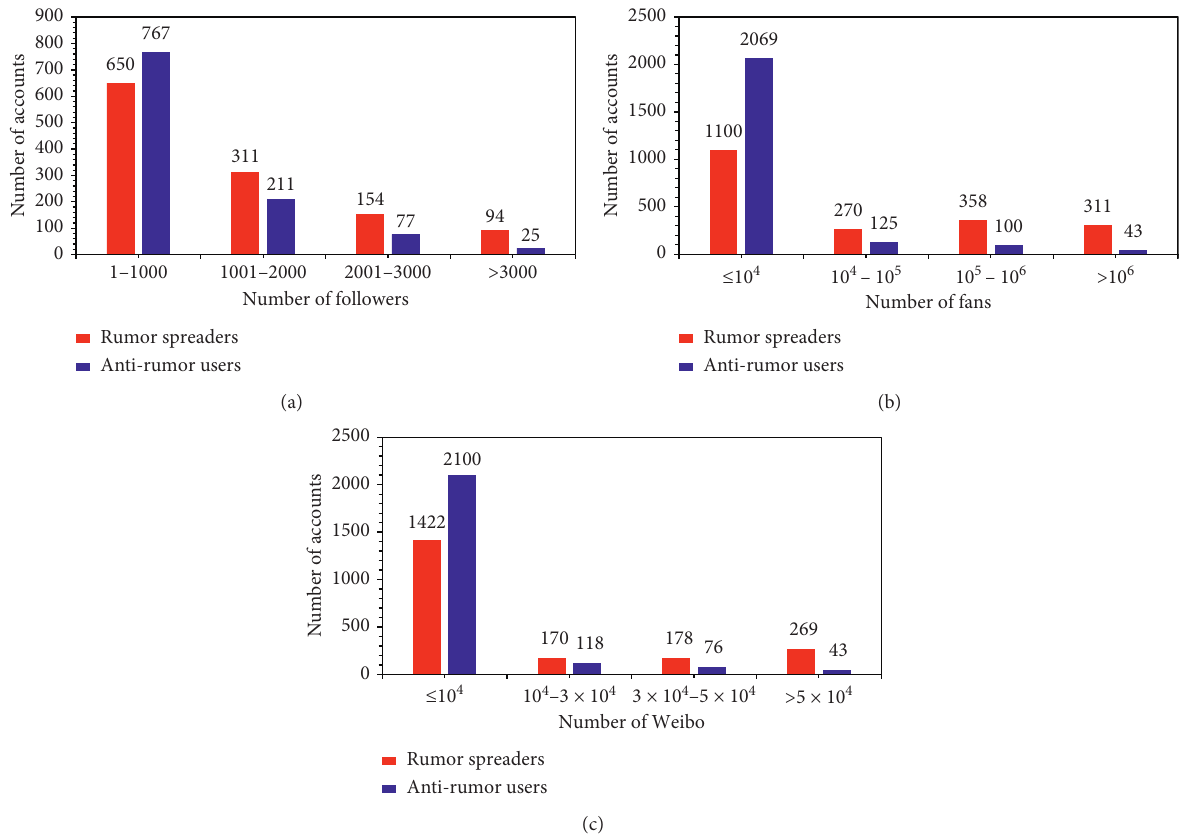
Figure 3: Distributions of followers, fans, and posts in Sina Weibo. (a) Distributions of followers. (b) Distributions of fans. (c) Posts in Sina Weibo.